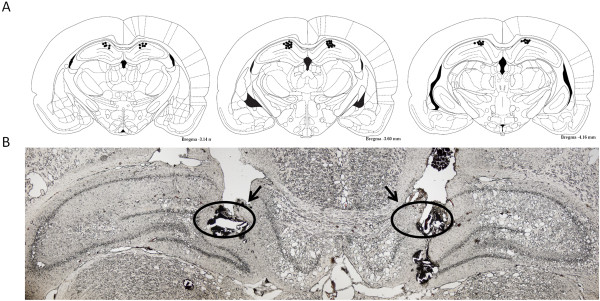
Confirmation of cannula placement in the hippocampus. (A) Reconstruction of serial coronal sections of the brain illustrates the bilateral injection sites of the cannulas. The black dots on the schematic illustration of the coronal section of rat brain indicate the placements of cannulas in the brain. (B) Representative microphotograph of the coronal section shows the placements (indicated by circles and arrows) of a pair of cannulas in the CA1 region of the hippocampus.